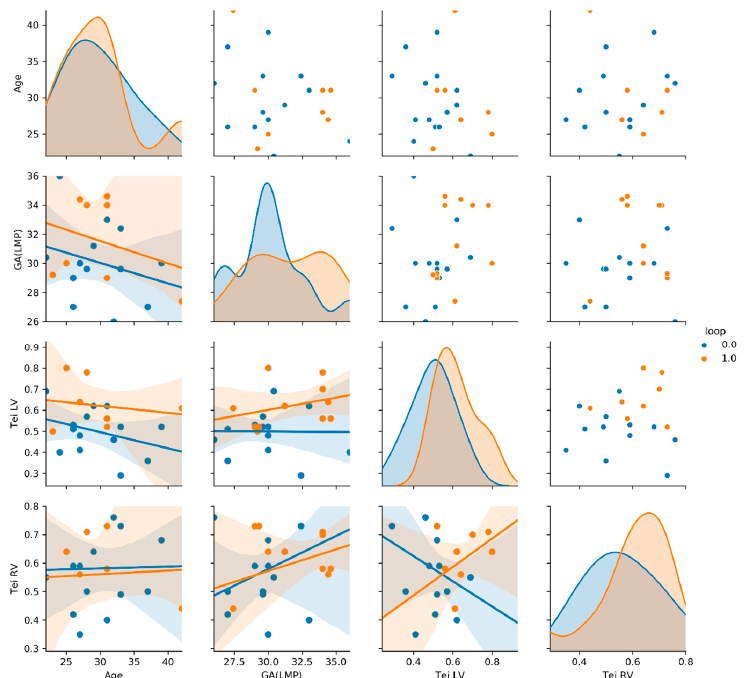
Figure 5. Correlogram of Tei LV, Tei RV, maternal age and gestational age in LGA with NC presented in red dots (loops 1,0) ( n = 11) vs. LGA without NC = nNC group, presented in blue dots (loops 0,0) ( n = 14) studied patients visualized with pair-plots in Python. A pair-plot allows one to observe both distributions of single variables and relationship between two variables. For more explanation see statistical analysis in this article